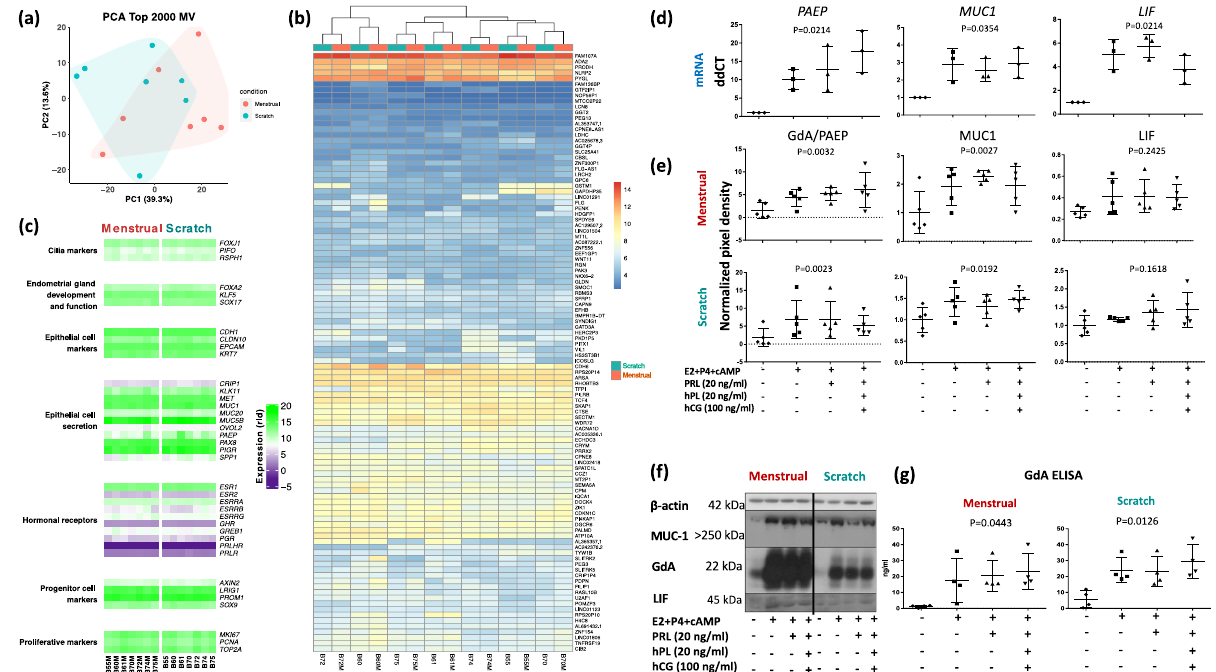
Fig. 2 Comparative characterisation of menstrual and scratch organoids and their response to hormones. a PCA plot shows top 2000 variable genes clustering of organoids derived from scratch biopsies and menstrual fl ow of seven patients analysed by RNA-Seq. b A heatmap of scratch and menstrual organoids demonstrates pairing of organoids in each of seven patients using the 101 differential expressed genes with threshold p adj < 0.05, abs(log2Fold- Change) > = 1. c A heatmap validating expression of epithelial, secretory and stem cell markers in scratch and menstrual organoids. d , g Menstrual fl ow organoids are hormonally responsive. Organoids were grown for 4 days, and treated with culture medium alone or β -estradiol for 2 days followed by β - estradiol, progesterone and cAMP (EPC), EPC plus prolactin, or EPC plus prolactin, hPL and hCG for 4 days. d mRNA of PAEP , LIF and MUC1 was quanti fi ed using qRT-PCR in hormonally treated menstrual organoids ( n = 3). Statistical signi fi cance was assessed using ANOVA, p -values are shown on each graph. e , f Menstrual fl ow and scratch organoids ( n = 5 each) responded similarly to hormones at the protein level. PAEP/glycodelin, MUC1 and LIF were